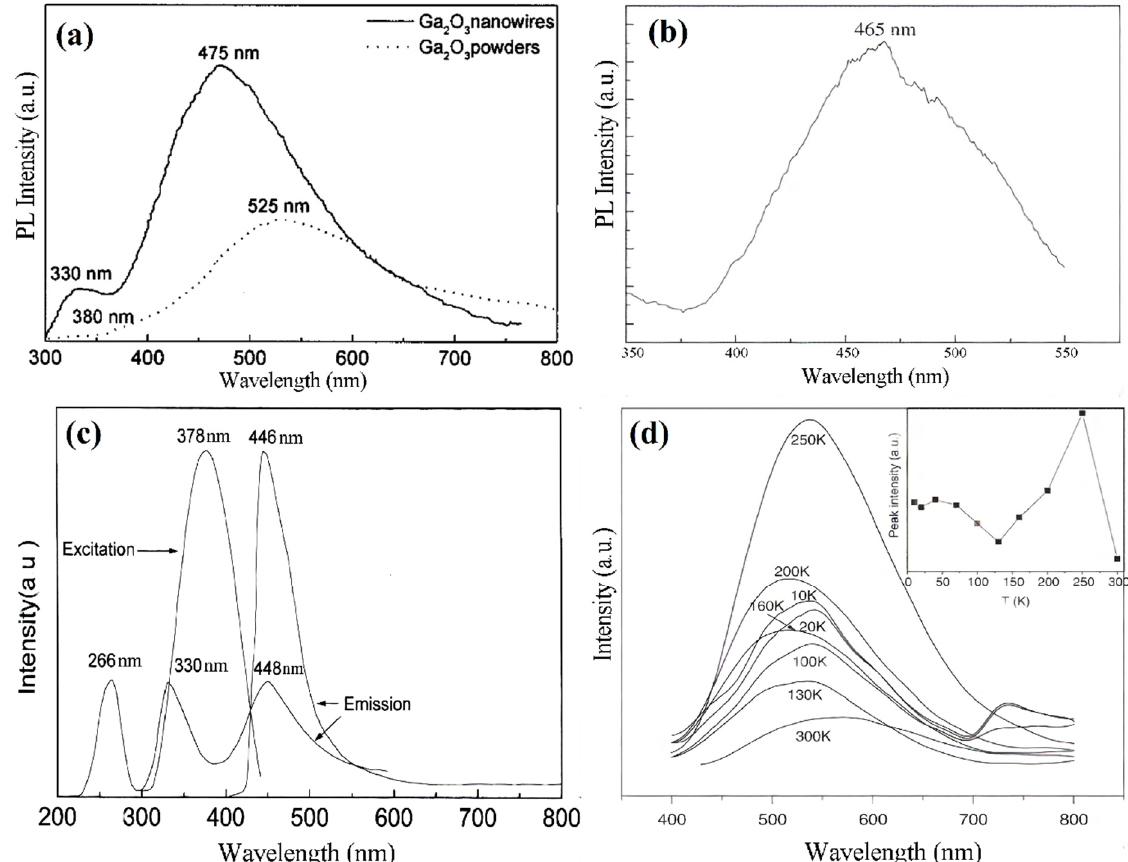
Figure 14. The photoluminescence of gallium oxide nanostructures ( a ) blue emission peak at 250 nm excitation [172]. “Reprinted with permission from Ref. [172]. Copyright (2001), AIP Publishing”. ( b ) blue emission peak 250 nm excitation [173]. “Reprinted with permission from Ref. [173]. Copy- right (2005), Elsevier.”. ( c ) blue emission at 446 nm and UV emission at 330 nm [180]. “Reprinted with permission from Ref. [180]. Copyright (2000), Elsevier.”. ( d ) green emission at 10 K and 300 K temperature excitation [181]. “Reprinted with permission from Ref. [181]. Copyright (2006),